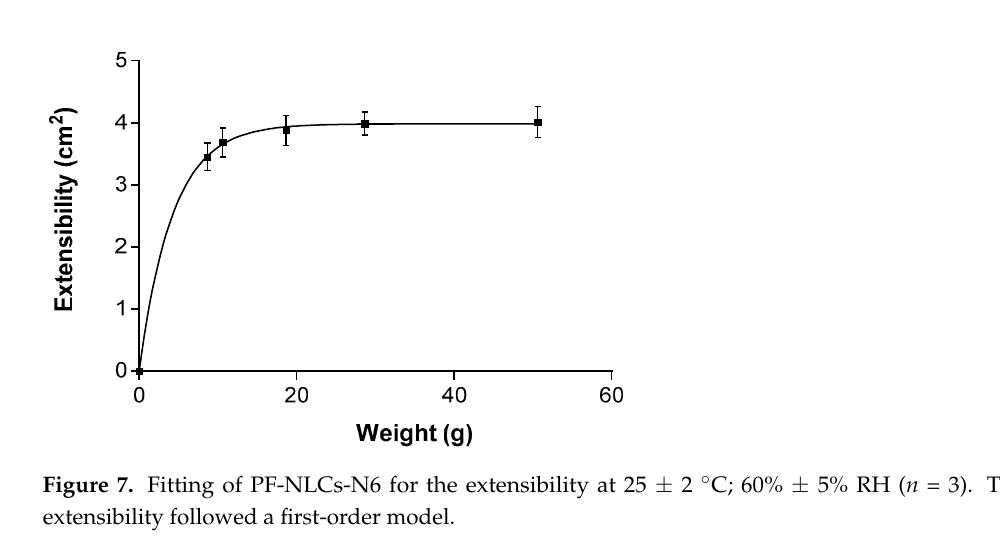
11 of 24 Figure 6. Rheological behaviour of PF-NLCs-N6.